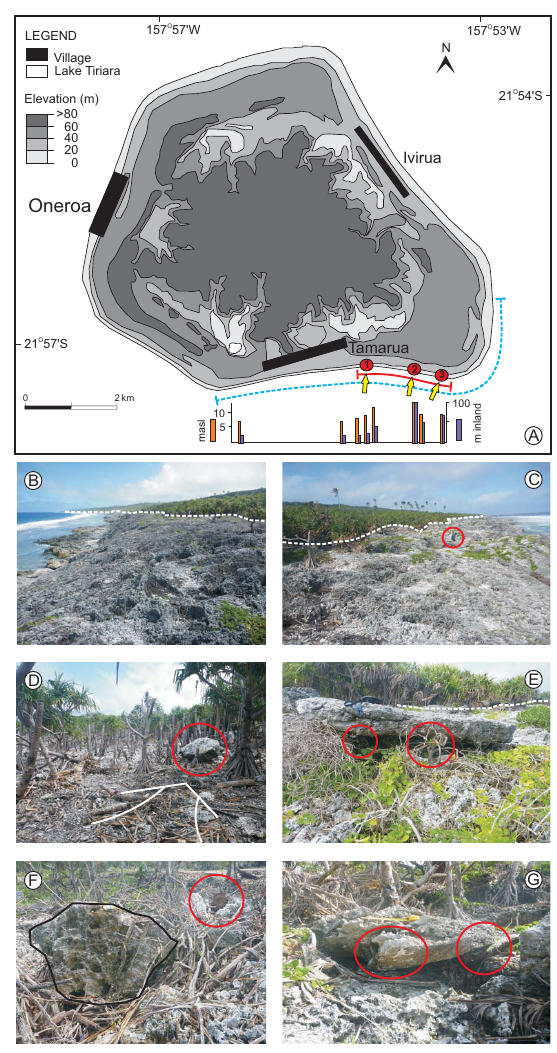
Fig. 2. (A) Map of Mangaia showing the approximate location of the three main villages. Red circles mark the location of Points 1–3 discussed in the text, the red solid line marks the extent of the main study area and the blue dashed line shows the inundation-affected coastline. The orange and purple bars indicate measured points of inundation and runup, respectively. Yellow arrows indicate mean A-axis orientations of boulders at Points 1–3. (B) Photo taken from Point 1 looking west. (C) Photo taken from Point 1 looking east, red circle shows person for scale. Snapped pandanas tree trunk in centre left of photo. (D) Photo taken at Point 2 showing a patch of snapped pandanas trees with coral boulder (ringed in red) overly- ing crushed vegetation. (E) Photo taken at Point 3 showing coral boulder crushing live vegetation (ringed in red) (F) Point 1 – photo looking north with large coral boulder tilted on its side overlying and overlain by dead vegetation. Red circle shows intact pandanas tree and root system deposited among debris. (G) Impact marks on underside of coral boulder (left circle) which overlies pandanas tree trunk (right